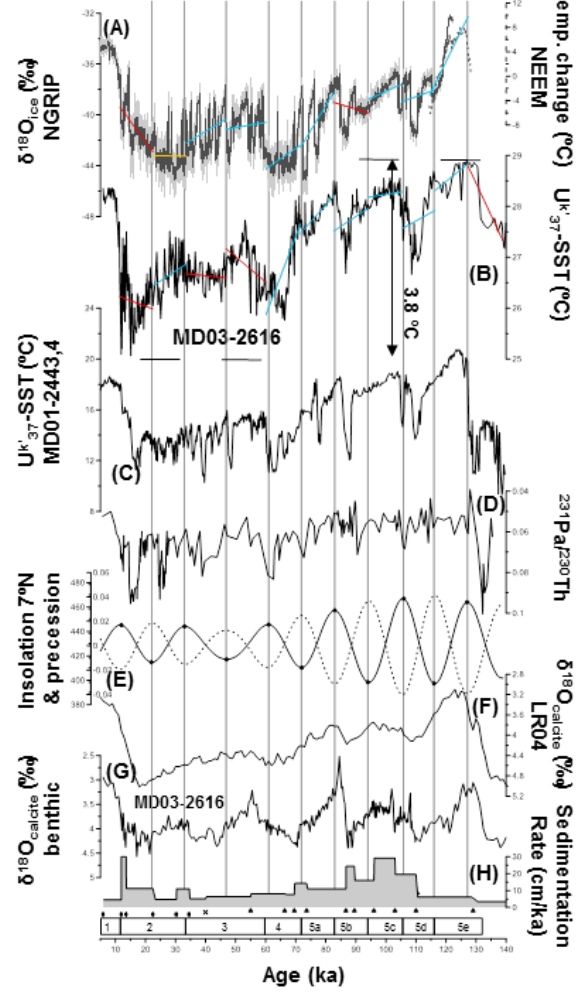
Figure 2. Guiana SSTs vs. Greenland and orbital changes. (a) δ 18 O ice (‰) NGRIP (GICC05 modelext timescale; Wolff et al., 2010; Svensson et al., 2011) and temperature change in NEEM (dashed line; NEEM community members, 2013), (b) MD03-2616 (cid:48) (cid:48) -SST (Martrat et al., U k -SST (this study). (c) MD01-2443,4 U k 37 37 2007), (d) 231 Pa/ 230 Th composite (Bohm et al., 2015, McManus et al., 2004), (e) precessional changes (dashed line), which are in- versely related to the daily insolation at 7 ◦ N (solid line) during the summer solstice (Berger, 1978). Circles mark maximum and min- imum of insolation at 7 ◦ N. (f) LR04 stack (Lisiecki and Raymo, 2005). (g) MD03-2616 δ 18 O calcite benthic (López-Otálvaro et al., 2009), (h) sedimentation rate of MD03-2616 (this study). The con- trol points used for the age model (Table 1) are shown: dots for AMS- 14 C dates, a cross for the Y bioclimatic event, and trian- gles for tie points between MD03-2616 benthic isotopes (López- Otálvaro et al., 2009) and the LR04 stack (Lisiecki and Raymo, 2005). The trends between the perihelion passage in the NH boreal summer (precession minima, insolation maxima) and winter sol- stices (precession maxima, insolation minima) are